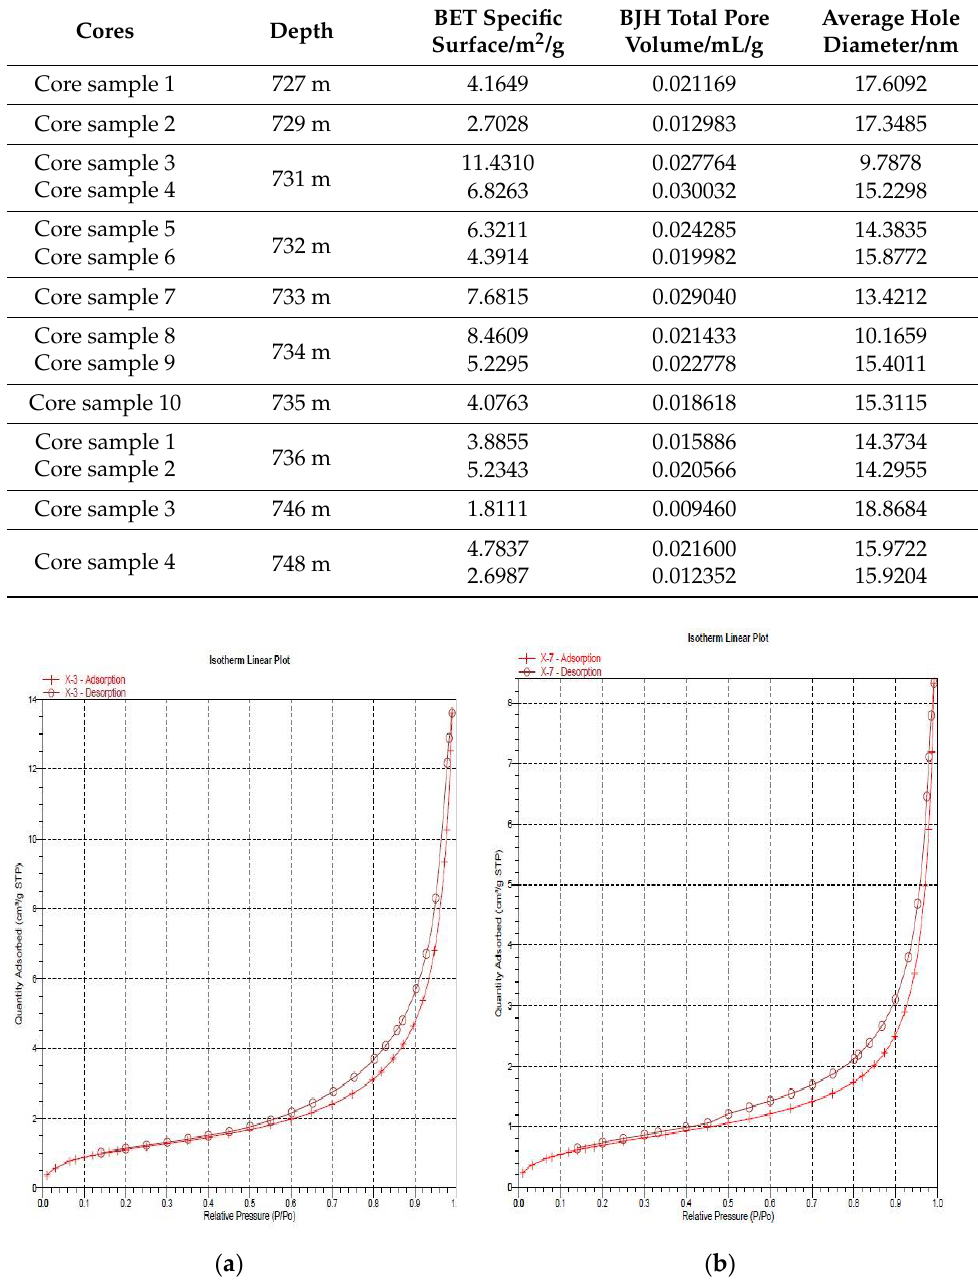
Table 2. Pore characteristics of the studied rock samples obtained using isothermal nitrogen adsorption.